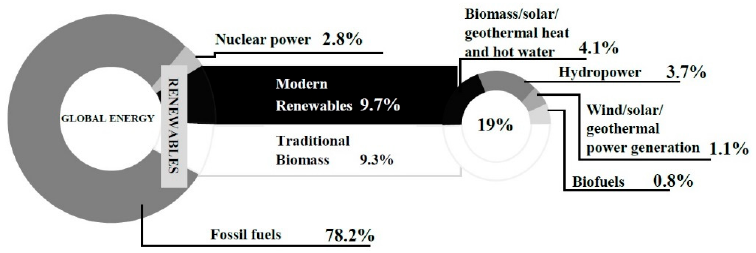
Figure 1. Estimated renewable energy share of global final energy consumption in 2011. Source: [2].